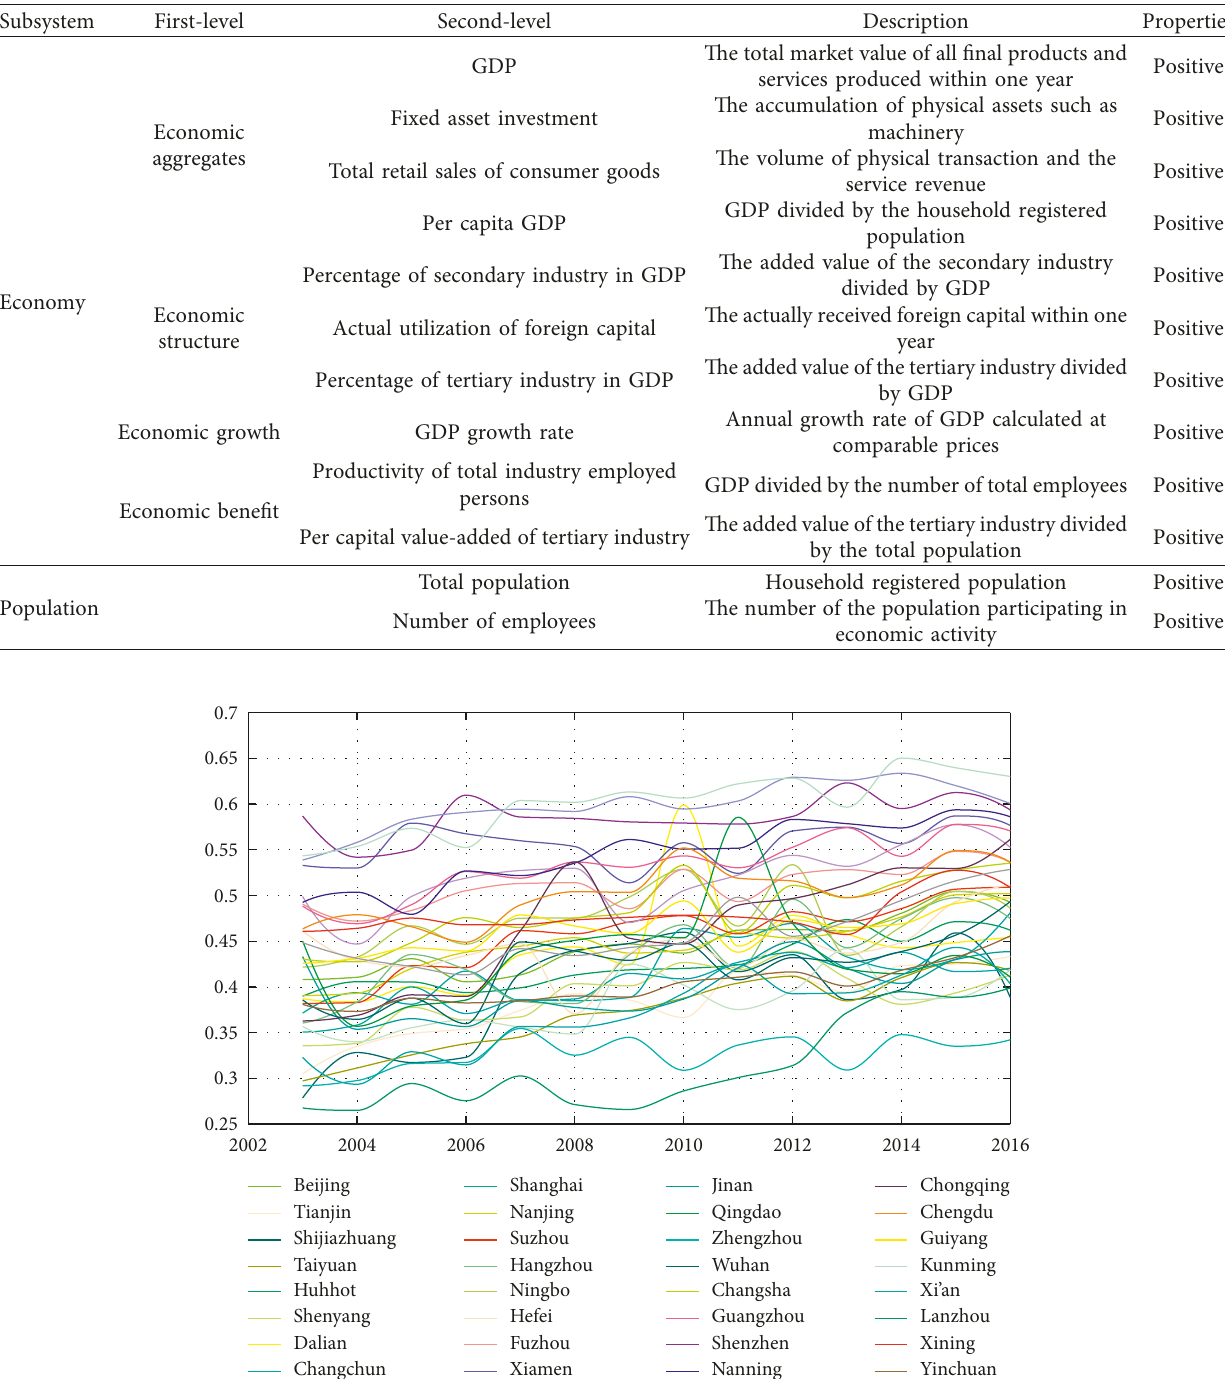
Table 2: Economic indicator system and population indicator system.